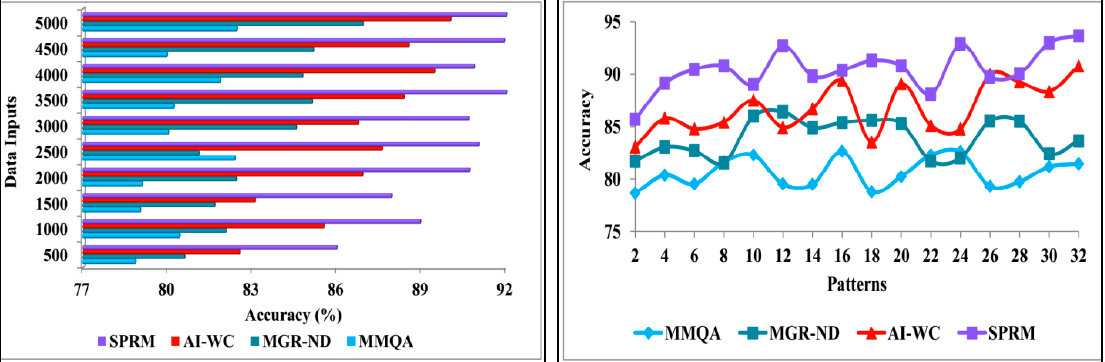
Figure 10. Accuracy analysis.